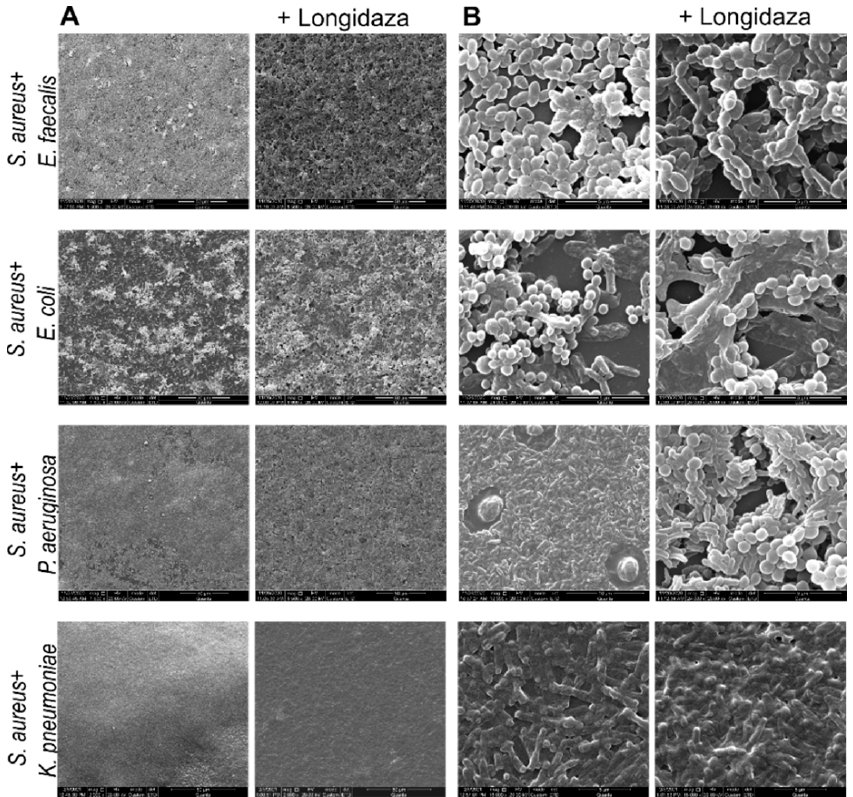
Figure 4. Scanning electron microscopy of 48-h old mixed biofilms of S. aureus with either E. faecalis, E. coli, P. aeruginosa or K. pneumoniae, treated for 24 h with Longidaza ® at concentration of 750 IU/mL. Magnification 1500× ( A ) and 24,000× ( B ).